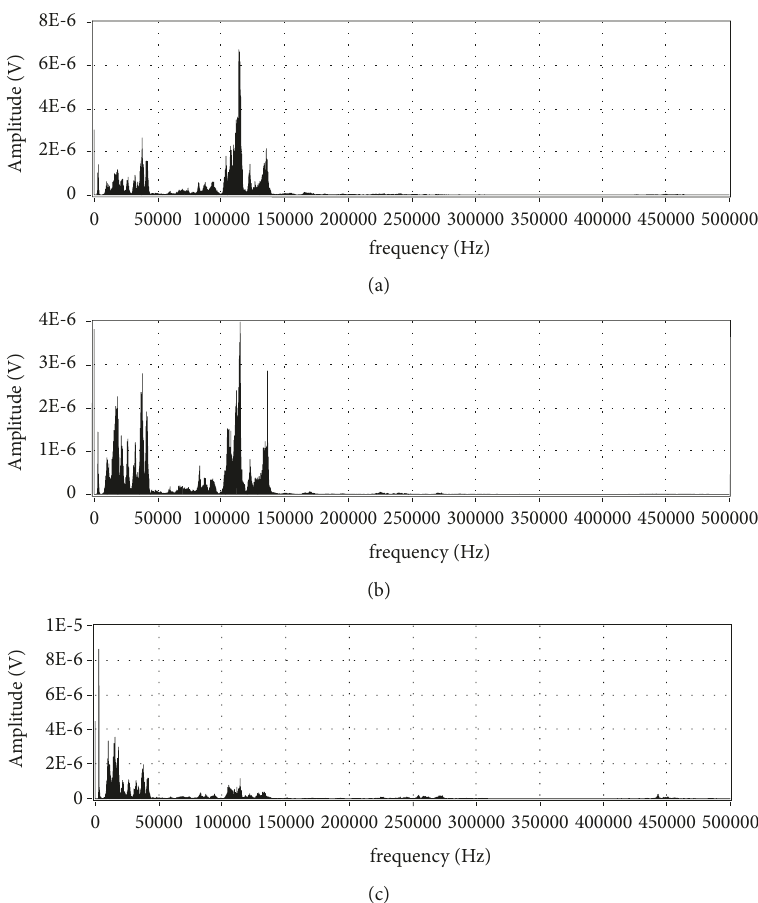
Figure 10: Frequency domain waveforms of AE signal: (a) initial tool wear; (b) normal tool wear; (c) severe tool wear (cutting speed 64.6m/min; feed speed 0.11mm/r; depth of cut 1.2mm).